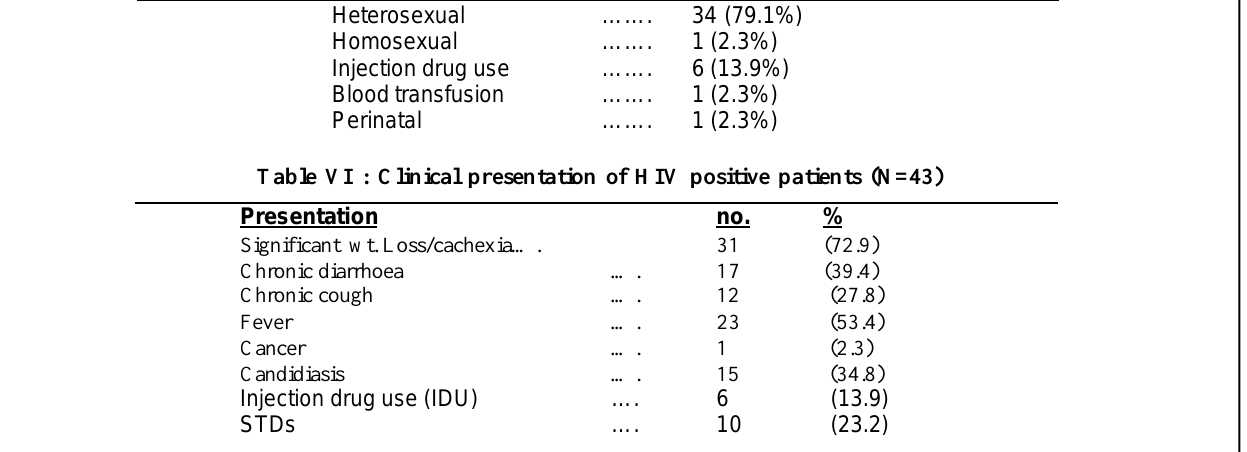
Table V : Possible mode of transmission of HIV positive patients